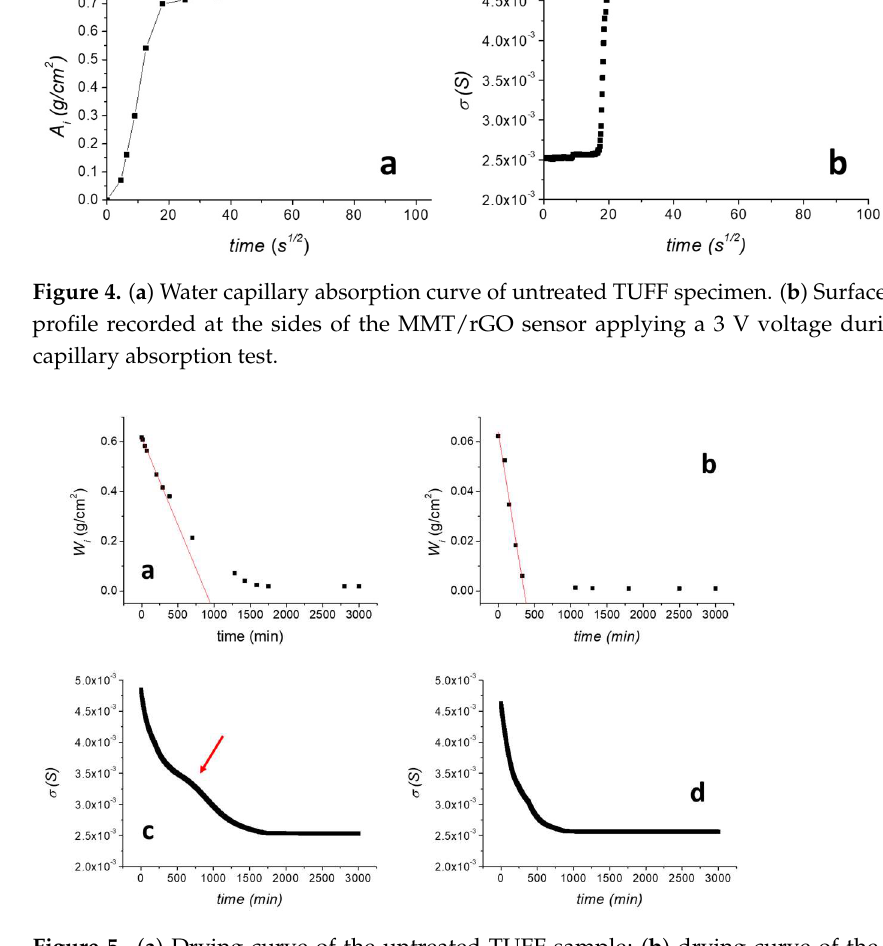
Figure 5. ( a ) Drying curve of the untreated TUFF sample; ( b ) drying curve of the consolidated TUFF-C sample; ( c ) surface conductivity of the sensor applied on the untreated TUFF sample during the drying test; ( d ) surface conductivity of the sensor applied on the consolidated TUFF-C sample during the drying